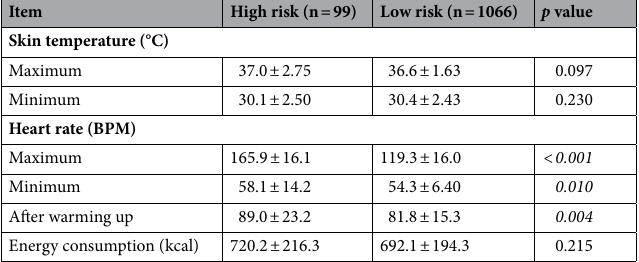
Table 3. Vital data. Italic font describes significant difference ( p < 0.05). Mean ± Standard deviation. p value was calculated by using Student’s t test.